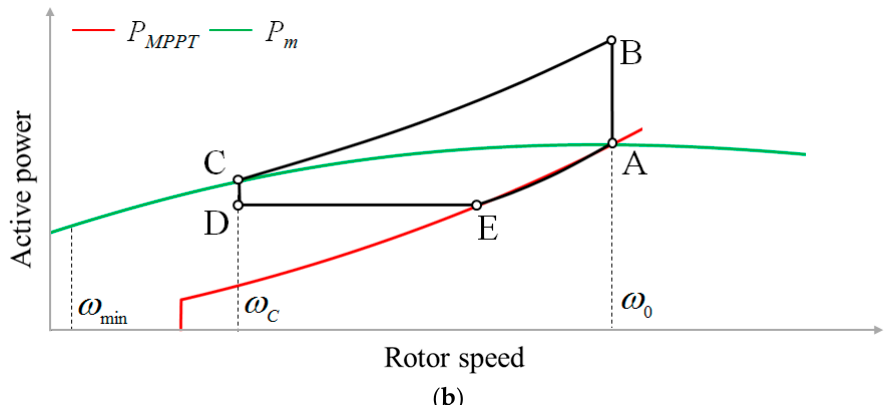
Figure 4. Power reference of SIC #2. ( a ) Power reference in the time domain; ( b ) Power reference in the rotor speed domain.